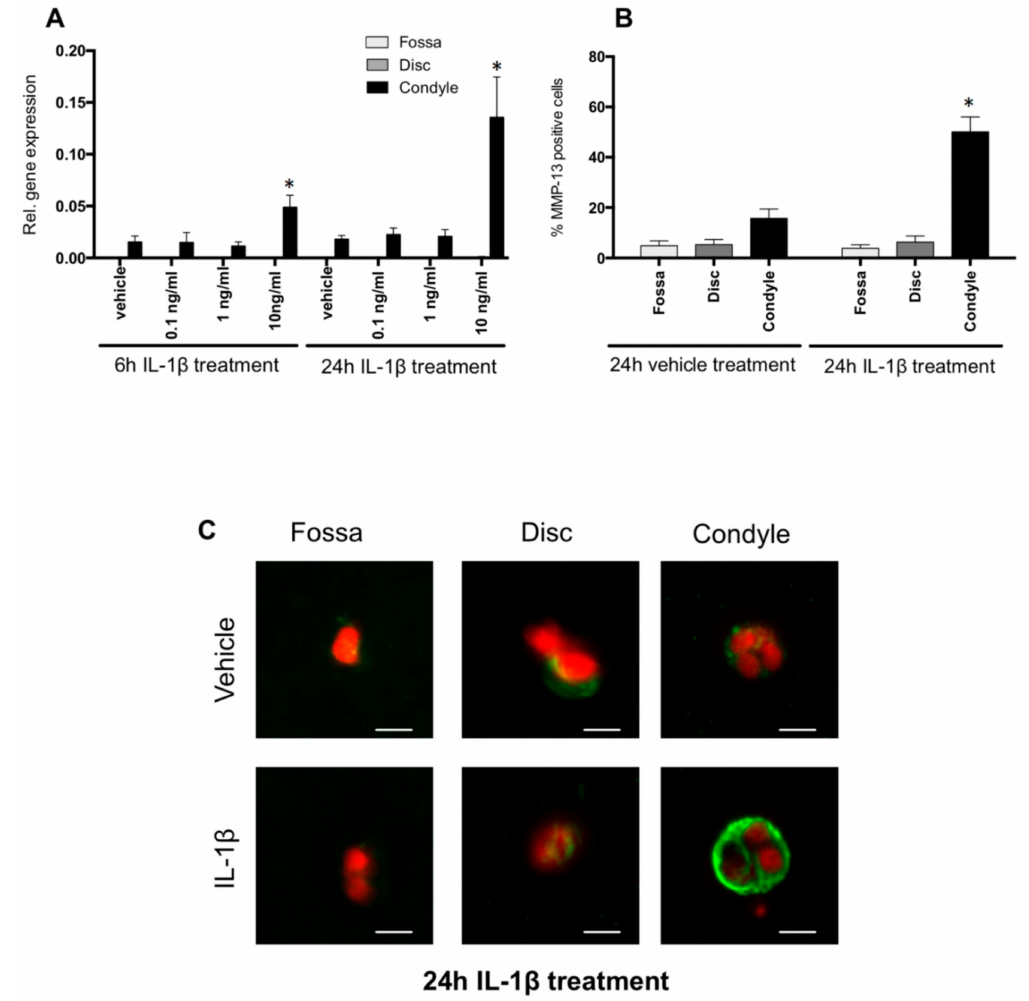
Figure 4. MMP-13 gene and protein expression. ( A ) MMP-13 gene expression by the cells from the fossa, disc, and condyle. IL-1 β for 6 h and 24 h at 10 ng / mL increased MMP-13 expression in condyle cells in comparison to vehicle. ( B ) Number of MMP-13-positive cells. Condylar cells incubated with 10 ng / mL IL-1 β for 24 h showed the highest number of MMP-13-positive cells. ( C ) Image of MMP-13-positive cells after 24 h of 10 ng / mL IL-1 β treatment. The green label indicates the presence of MMP-13, and the nuclei are red. * Significant e ff ect of treatment with IL-1 β relative to vehicle treatment, p < 0.05. Scale bar represents 5 µ